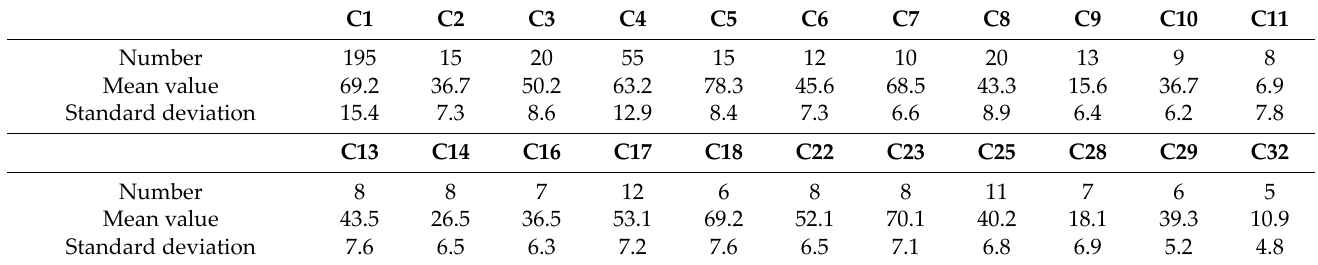
Table 1. Statistical information of the clustering results by our method.